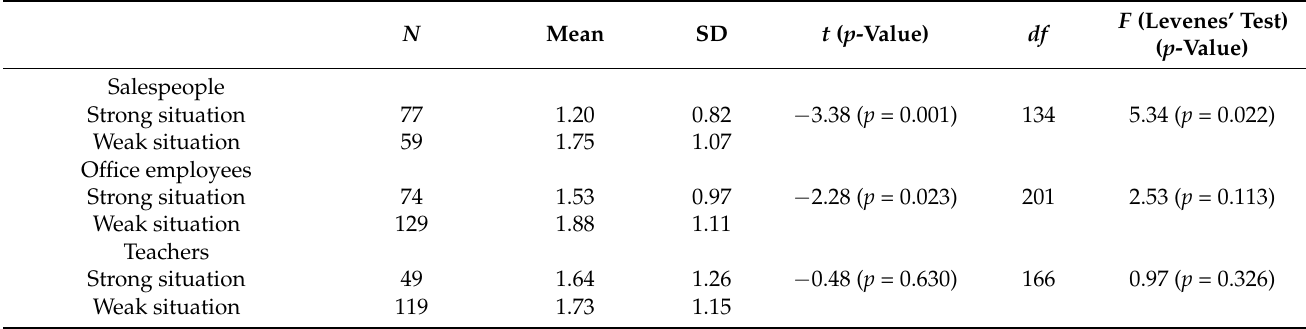
Table 3. Mean differences ( t -test) and variability (homogeneity of variances Levenes’ test) of strong/weak situations associated with burnout.